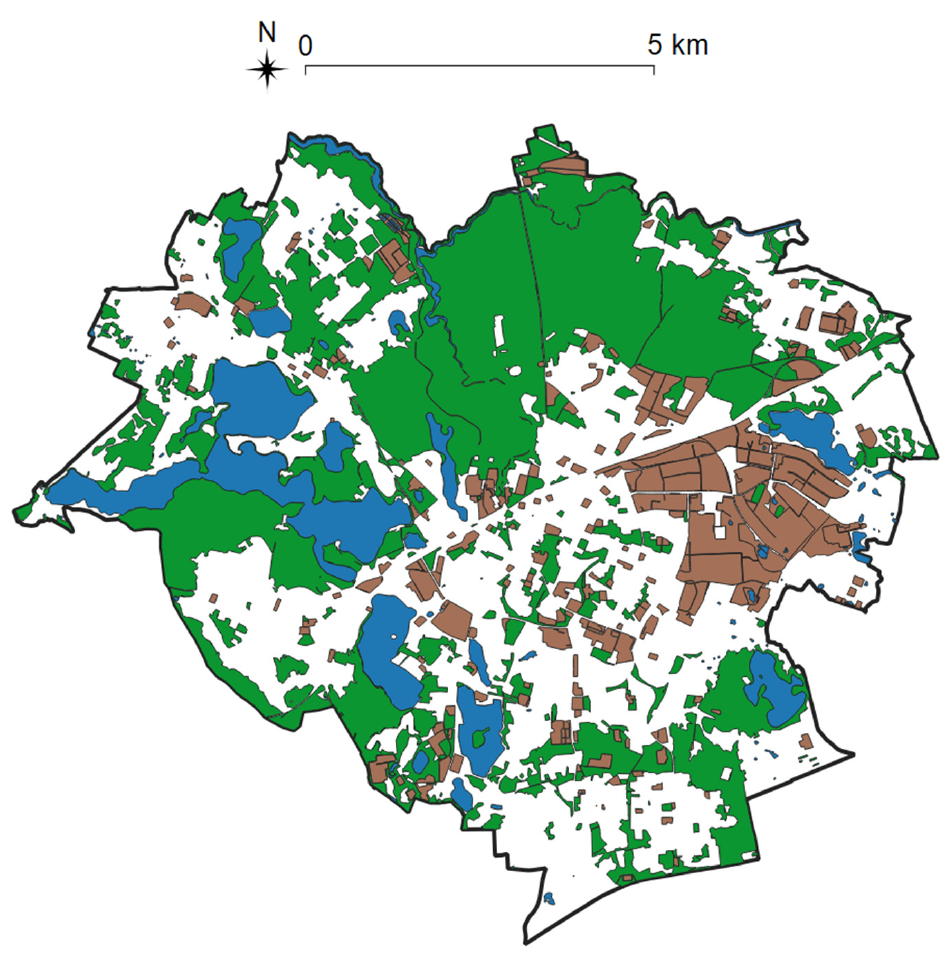
Figure 4. Location of woodlands (green), water reservoirs (blue), and industrial areas (brown) in Olsztyn. Source: own elaboration.